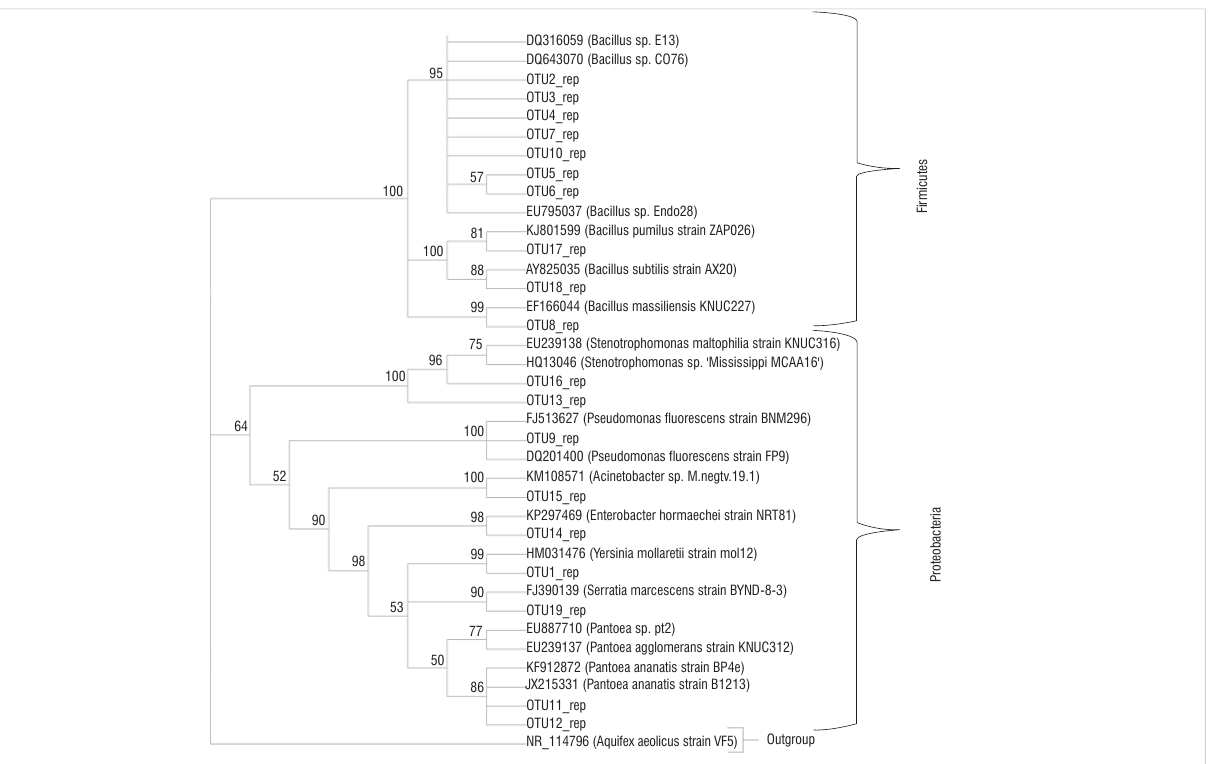
Figure 3: Phylogenetic relationship of representative operational taxonomic units (OTUs) of 50-day-old Bt and non-Bt bacterial isolates based on 16S rDNA gene and closely related sequences (Jukes–Cantor algorithm and neighbour-joining tree). Bootstrap values are based on 1000 replicates and are indicated in branches; Aquifex aeolicus was used as an outgroup.